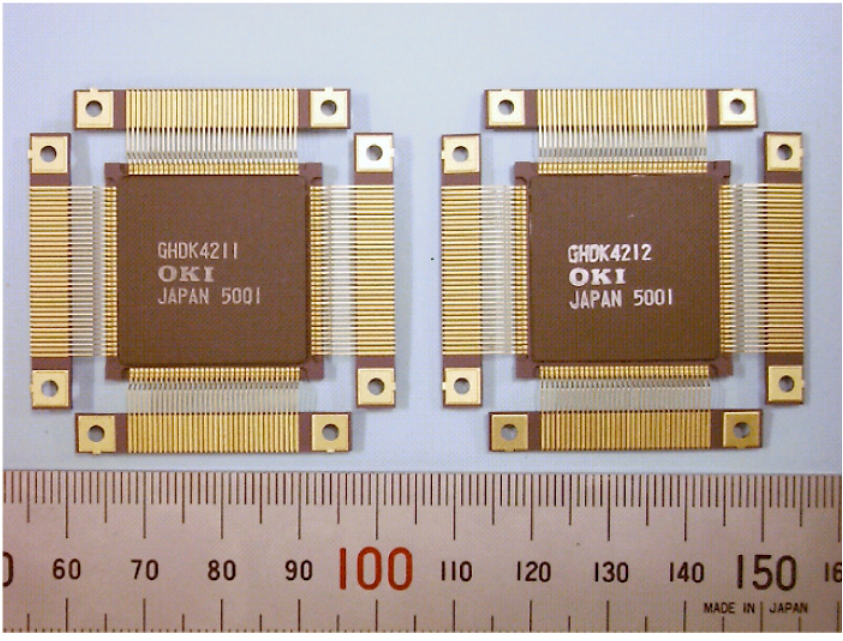
FIG. 2. (Color) Bottom views of FDMUX (GHDK4211) and FMUX